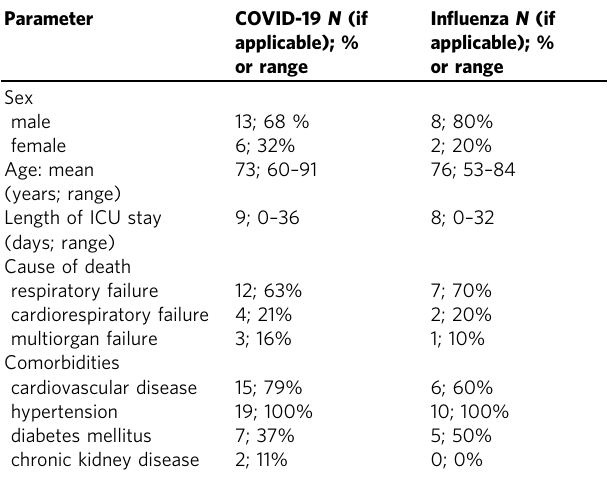
Table 1 Clinical characteristics of